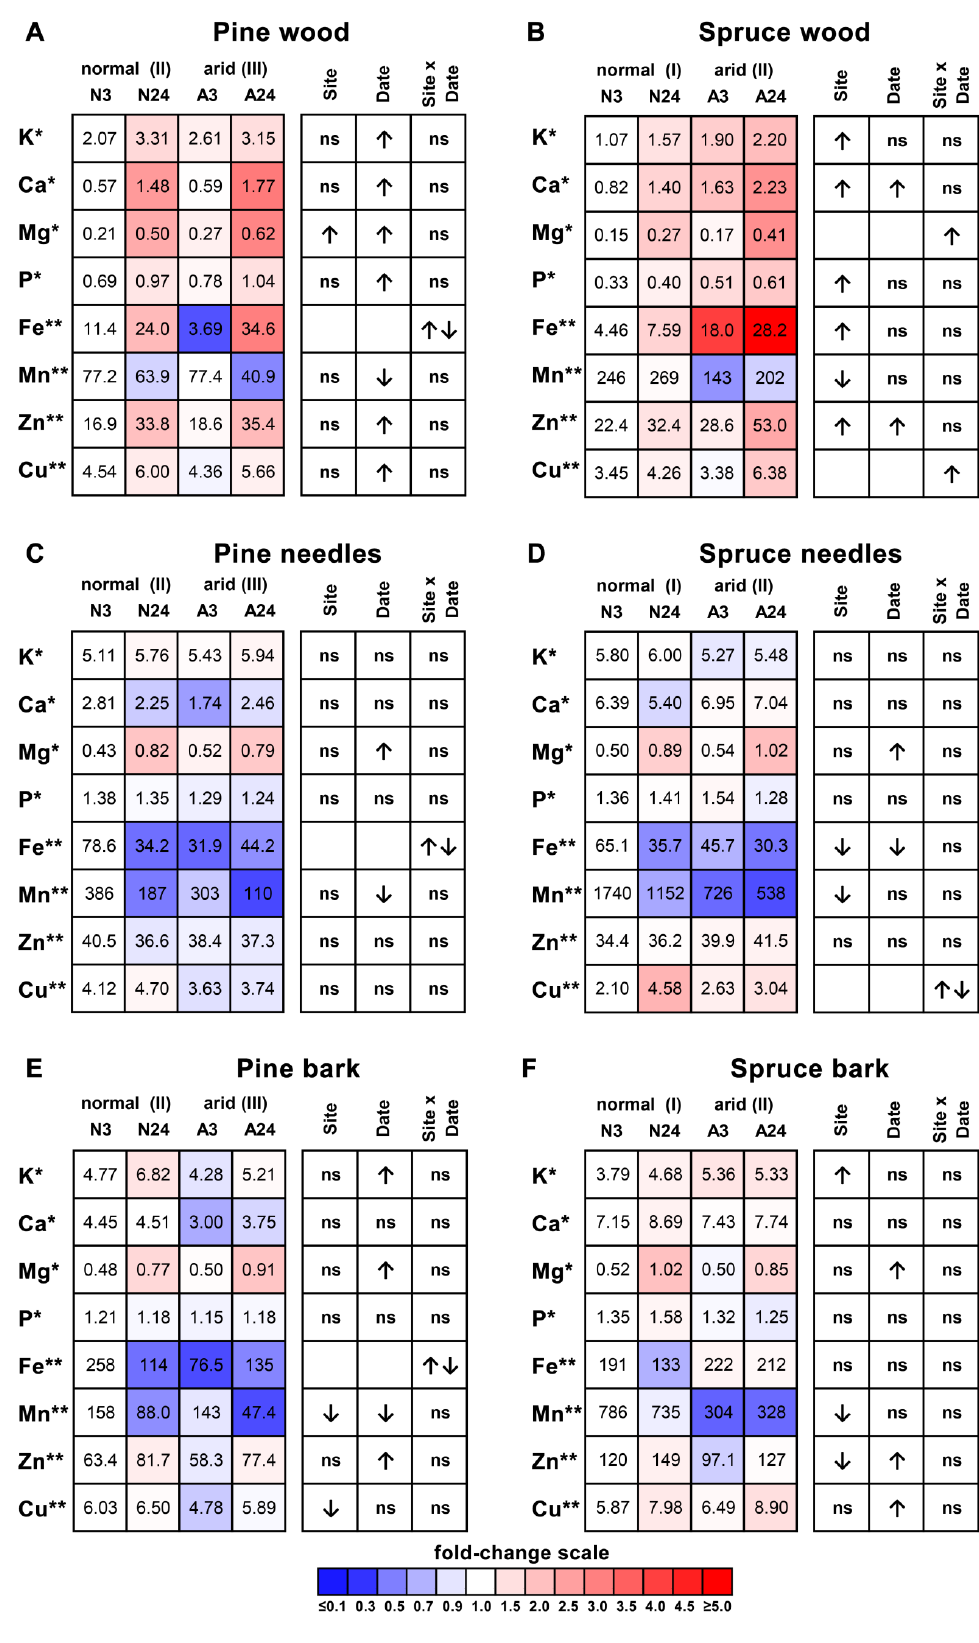
Figure 2. Nutrient contents in the wood ( A , B ), needles ( C , D ), and bark ( E , F ) of pine ( A , C , E ) and spruce ( B , D , F ). The nutrient contents on 3 August in the normal plot were taken as 1.0 (white),